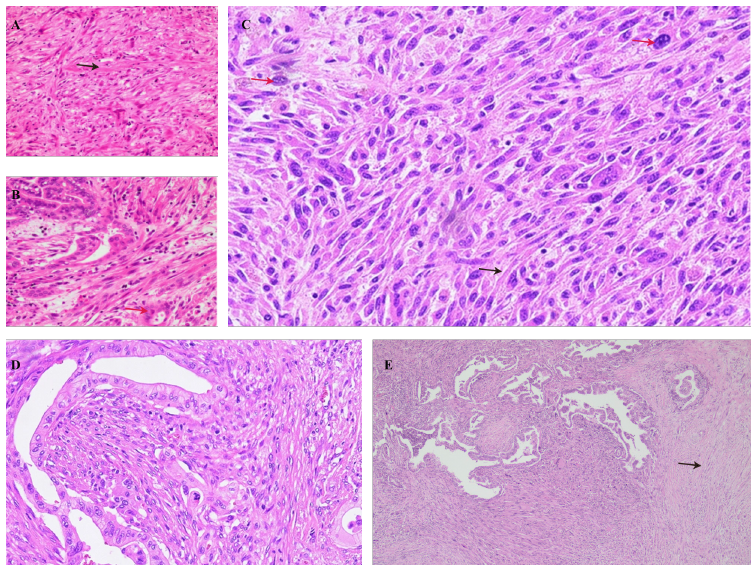
Figure 2. Histopathologic findings of sarcomatoid carcinoma of the pancreas showing the sarcoma- like appearance, spindle-shaped cells (black arrows) and pleomorphic cells (red arrows). ( A , B ) HE at 10×; ( C , D ) HE at 20×; ( E ) HE at